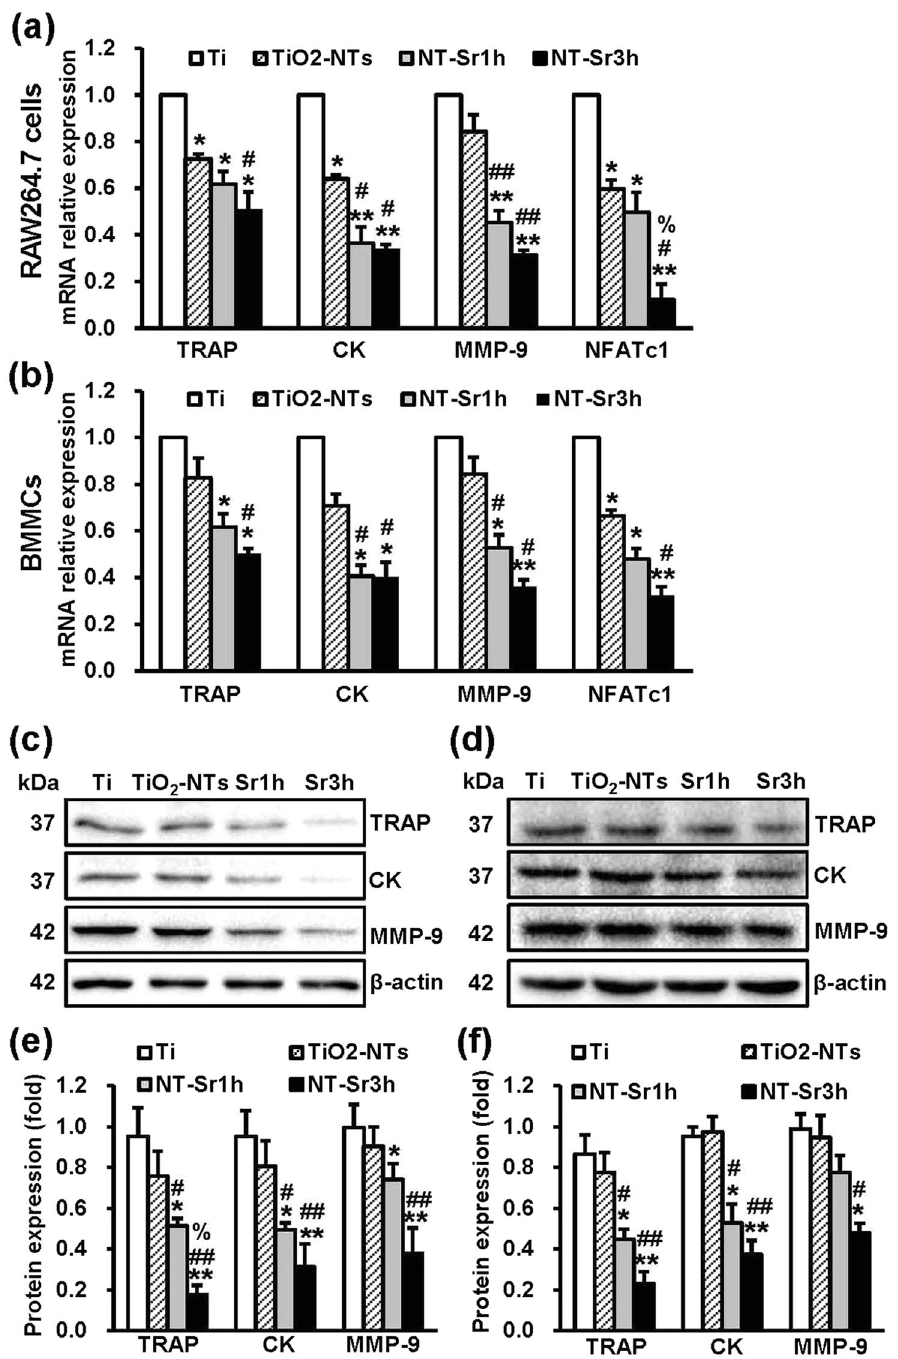
Figure 5. NT-Sr repress osteoclast-specific genes. RAW264.7 cells ( a ) and mouse BMMCs ( b ) were cultured on different samples and induced with 50 ng/mL RANKL and 30 ng/mL M-CSF (for BMMCs), and the total RNA was then collected. The relative mRNA expression levels of osteoclast-specific genes (TRAP, CK, MMP- 9, and NFATc1) were assessed by qRT-PCR. For total protein extraction, RAW264.7 cells ( c , e ) and mouse BMMCs ( d , f ) were cultured on different samples in the presence of RANKL (50 ng/mL) and M-CSF (30 ng/ ml, for BMMCs). The protein expression of osteoclast markers (TRAP, CK, and MMP-9) was then detected by immunoblotting. An antibody to β -actin was used as a loading control. A quantitative analysis of the band densities was performed, and the band densities were normalised to the loading control. Full-length blots are presented in Supplementary Figure 2. Sr1h and Sr3h represent NT-Sr1h and NT-Sr3h, respectively. * , ** p < 0.05 and 0.01, respectively, compared with the Ti group, #,## p < 0.05 and 0.01, respectively, compared with TiO 2 -NTs, and % p < 0.05 compared with the NT-Sr1h group. At least three independent experiments were analysed, and the data are presented as the means ±